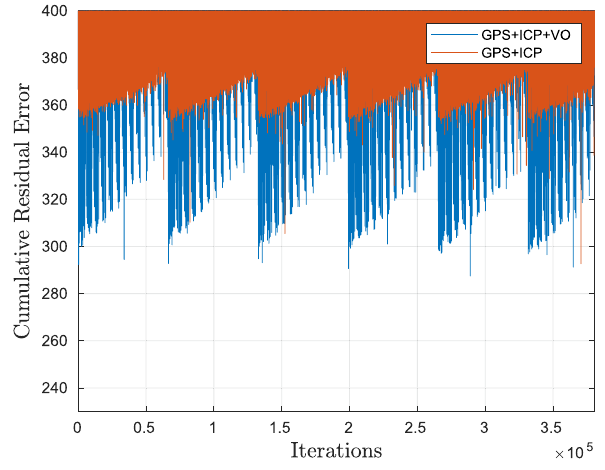
Fig. 7 Cumulative trajectory alignment error, in function of an expanded set of parameter combinations, with and without visual